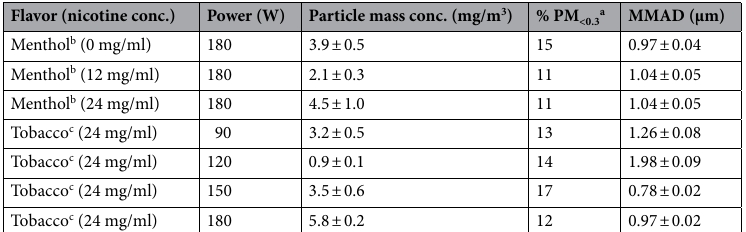
Table 1. Particle mass and size distribution data ± corresponds to the standard error of the mean (n = 16) mg/ ml milligrams per milliliter of e-liquid, W Watt, mg/m 3 milligrams per cubic meter of air, PM <0.3 particles with aerodynamic diameter less than 0.3 μm, MMAD mass median aerodynamic diameter, μm micrometer. a calculated using the mass of e-vapors collected on impactor stages, b ANOVA with Tukey HSD p = 0.133 c ANOVA with Tukey HSD p <